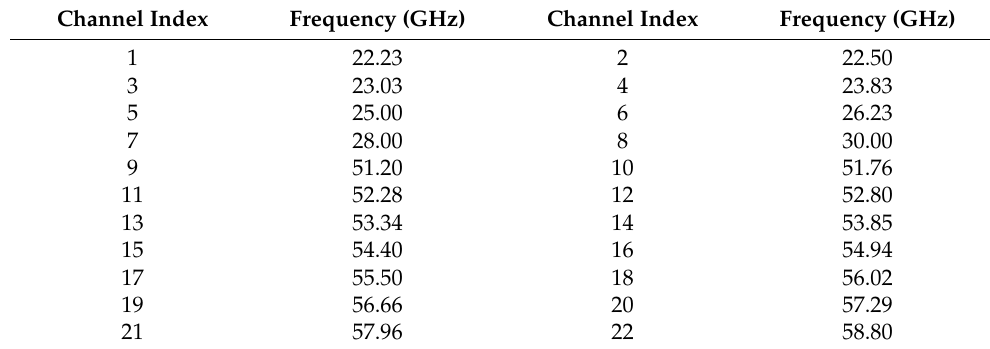
Figure 1. Scatter plots showing the dependence of cloud radiation contribution (K) on ( left panels) cloud water content (g/m 3 ) and ( right panels) cloud thickness (km) for channels 2, 7 and 10 (sequentially from top to bottom) of the microwave radiometer. Table 2. Radiometer channel frequencies used for atmospheric temperature and humidity remote sensing.